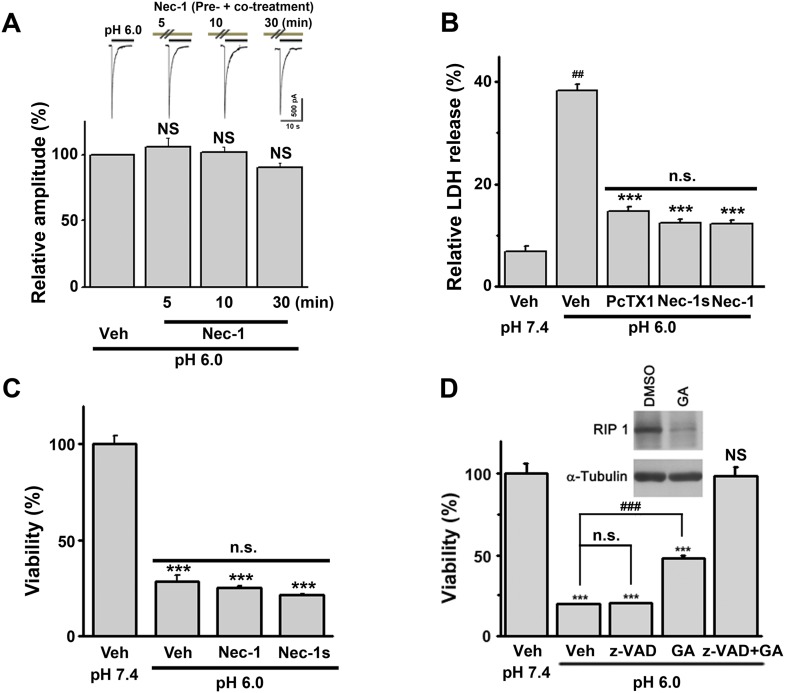
RIP1 mediates ASIC1a-dependent acid-induced neuronal death in cultured mouse cortical neurons.(A) No inhibitory effect of Nec-1 (40 μM, pre+co-treatment) on I6.0 in cultured mouse cortical neurons (n=5) was observed. Neurons were stimulated with the pH 6.0 solution and then treated with Nec-1 for 5, 10, and 30 min at pH 7.4 before the pH was switched to 6.0 in the presence of Nec-1. (B) Pre+co-application of 7-Cl-O-Nec-1 (Nec-1s, 20 μM), Nec-1 (20 µM), or PcTX1 (10 nM) with the pH 6.0 solution suppressed acidic neuronal death (LDH assay, n=3–5, ##p<0.001, vs vehicle (Veh) at pH 7.4; ***p<0.001, vs Veh at pH 6.0; n.s., no statistical significance, vs PcTX1). (C) No neuroprotection by Nec-1 and Nec-1s when co-administered with the pH 6.0 solution was observed (CTB assay, n=3–5, ***p<0.001, vs Veh at pH 7.4; n.s., no statistical significance, vs Veh at pH 6.0). (D) Geldanamycin (GA) treatment (1 mg/ml, 18 hr) decreased the RIP1 expression level and acid-induced neuronal death. Note: GA also caused cell death by apoptosis, which was abolished by z-VAD-fmk (CTB assay, n=3–5, ***p<0.001; NS, no statistical significance, vs Veh at pH 7.4; ###p<0.001; n.s., no statistical significance, vs Veh at pH 6.0).